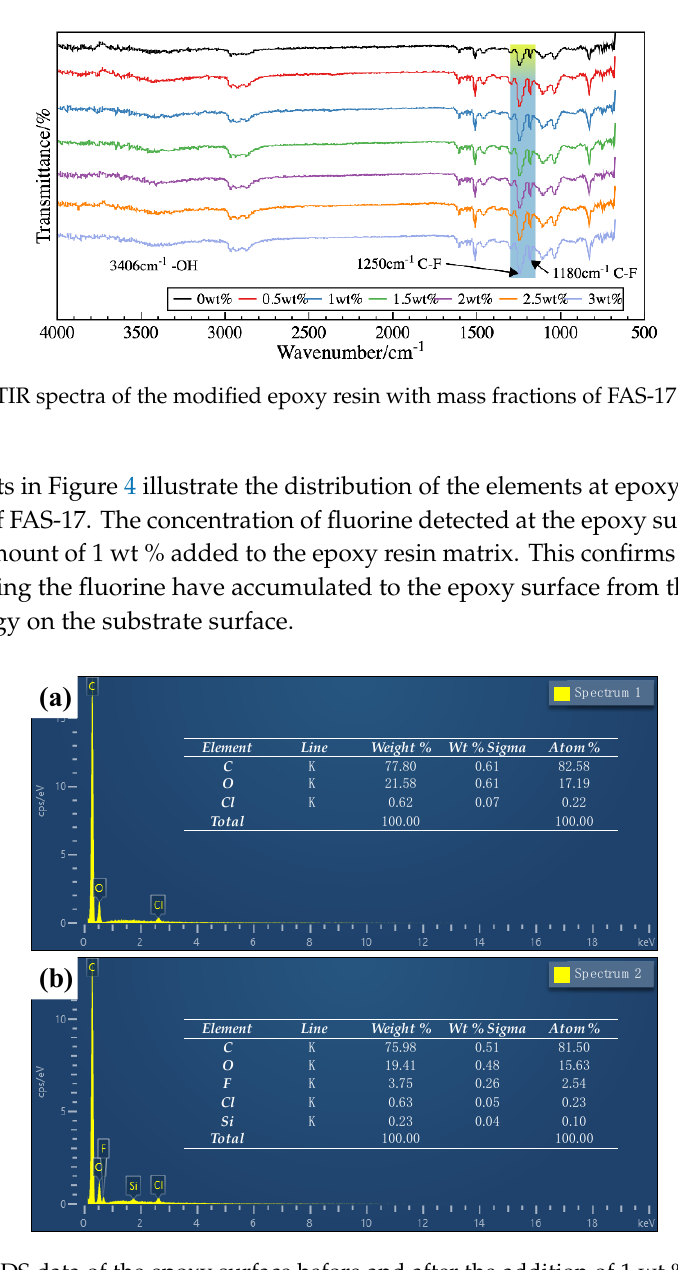
Figure 4. The EDS data of the epoxy surface before and after the addition of 1 wt % FAS-17: ( a ) EP, ( b ) F-EP (fluoridated epoxy).